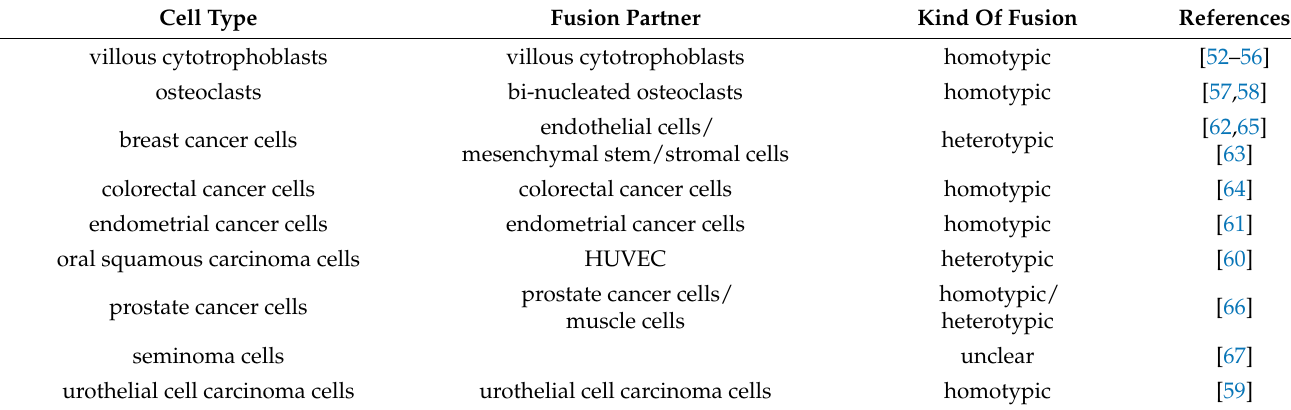
Table 1. Syncytin-1 expression and mediated fusion in normal human cells and human cancer